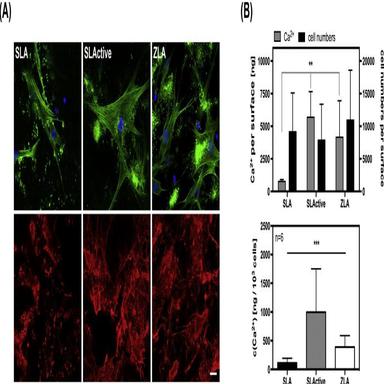
HBC cultured on top of implant surfaces pre-incubated in whole blood and the osseointegration potential of the surfaces analyzed. (A) Cell adhesion after 24h of culture was investigated with confocal microscopy after staining of the fibrin network (red), the actin cytoskeleton (green) and nuclei (blue) (scale bar 20 m). (B) After a culture period of 28d numbers of metabolically active cells were measured, the calcium levels were quantified (both top) and calcium levels per 1000 cells were calculated (botto